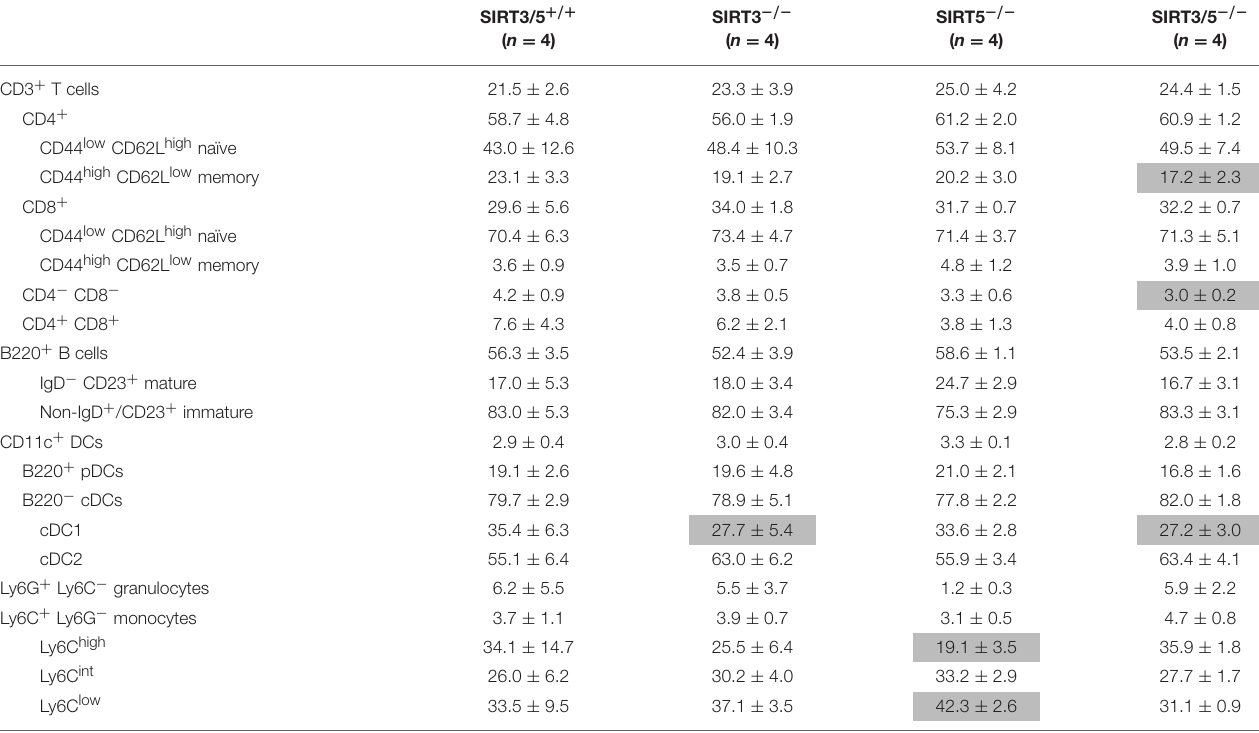
TABLE 3 | Splenic cell